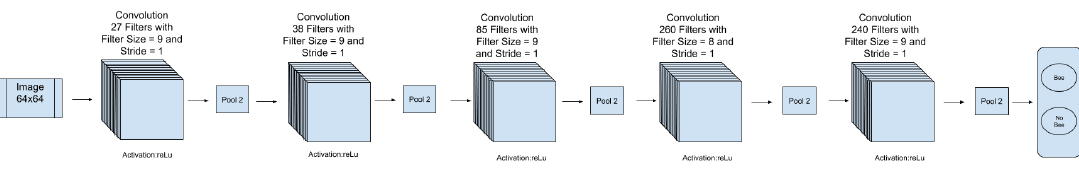
Figure A3. The architecture of ConvNetGS-5, the best performing auto-designed ConvNet on